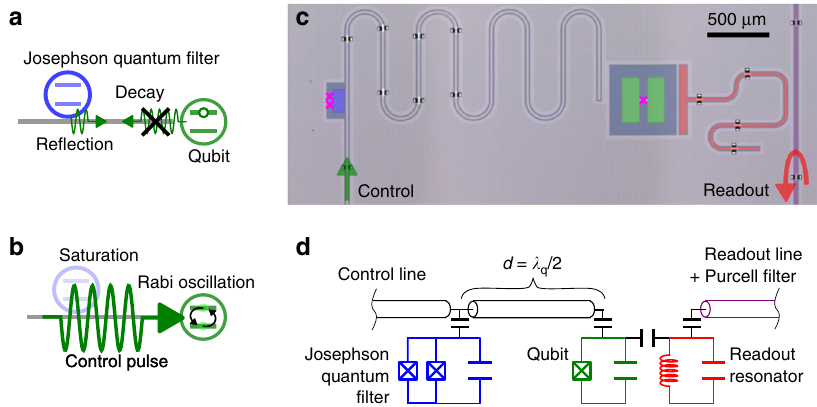
Fig. 1 Josephson quantum fi lter (JQF). a , b Concept of the JQF. The JQF re fl ects single photons emitted from the qubit, suppressing the qubit radiative decay. In contrast, when a large-amplitude control pulse is applied to the qubit, the JQF saturates and transmits the pulse, enabling fast qubit control. c , d False-colored optical image and equivalent circuit of the fabricated superconducting circuit. A fi xed-frequency transmon qubit acting as the data qubit (green) is connected to a control coplanar-waveguide with an ancillary tunable-frequency transmon qubit with a SQUID acting as the JQF (blue). The data qubit is coupled to a resonator (red) for fast dispersive readout via a readout line with a Purcell fi lter (purple). Air-bridges are fabricated on the waveguides to suppress spurious modes. The Josephson junctions are indicated by magenta